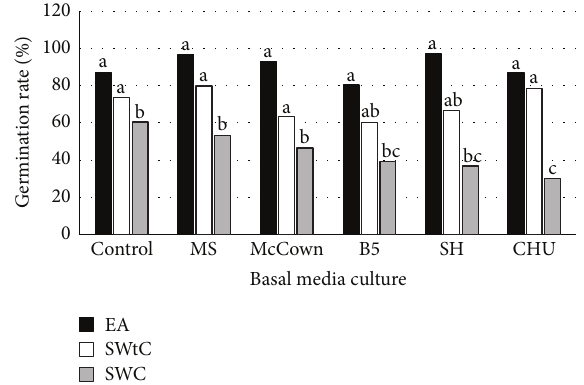
Figure 3: Germination rate of different seeds type of Bambara groundnut after three weeks of incubation on different basal